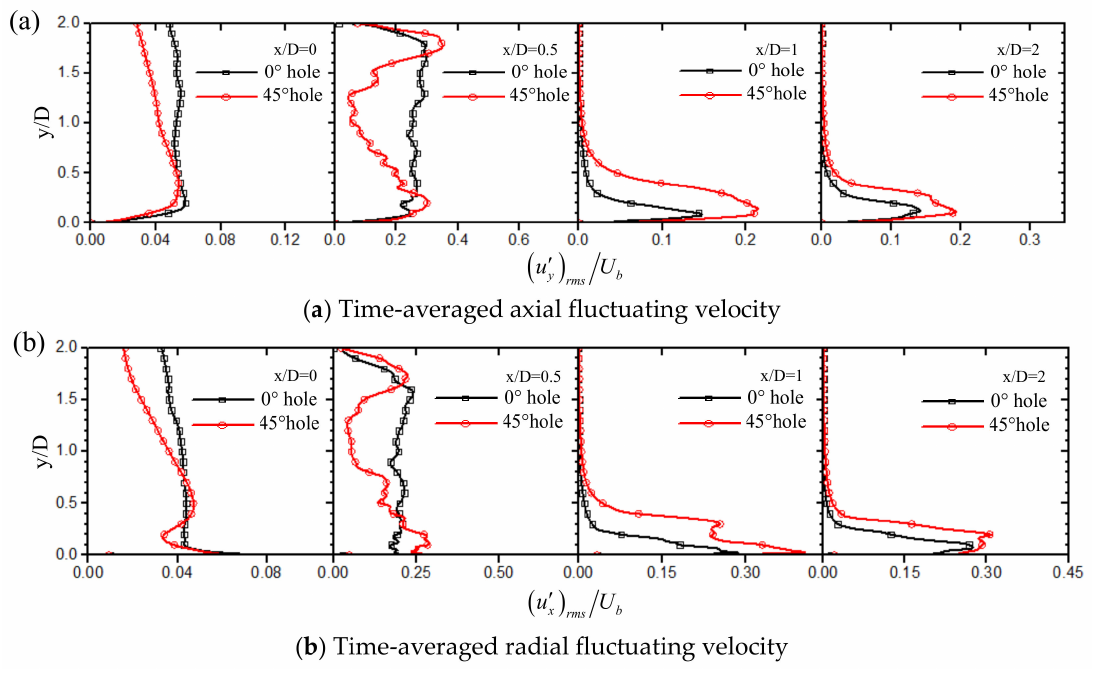
Figure 14. Distribution of root mean square of the axial and radial fluctuating velocities.